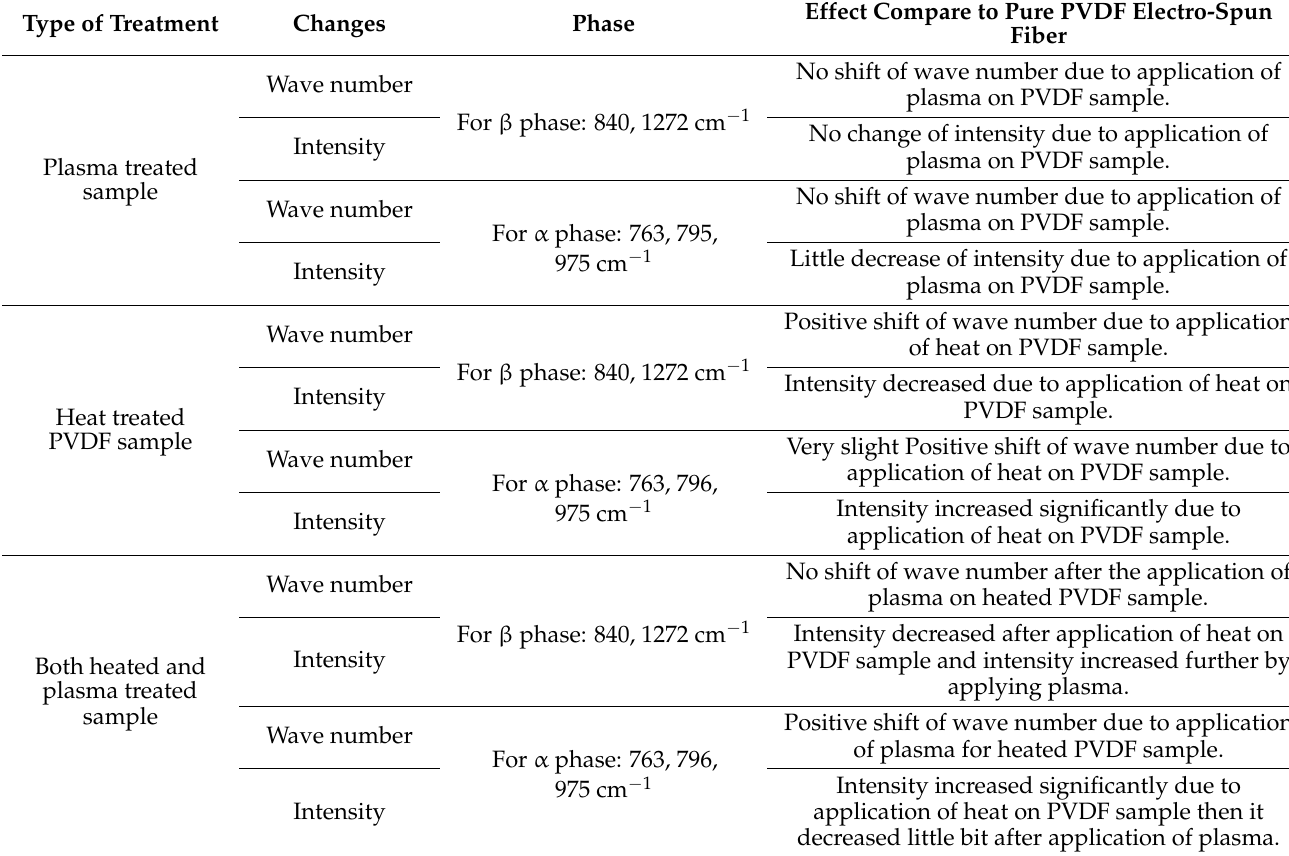
Table 2. FTIR wave number and comparison of different PVDF fiber for α and β